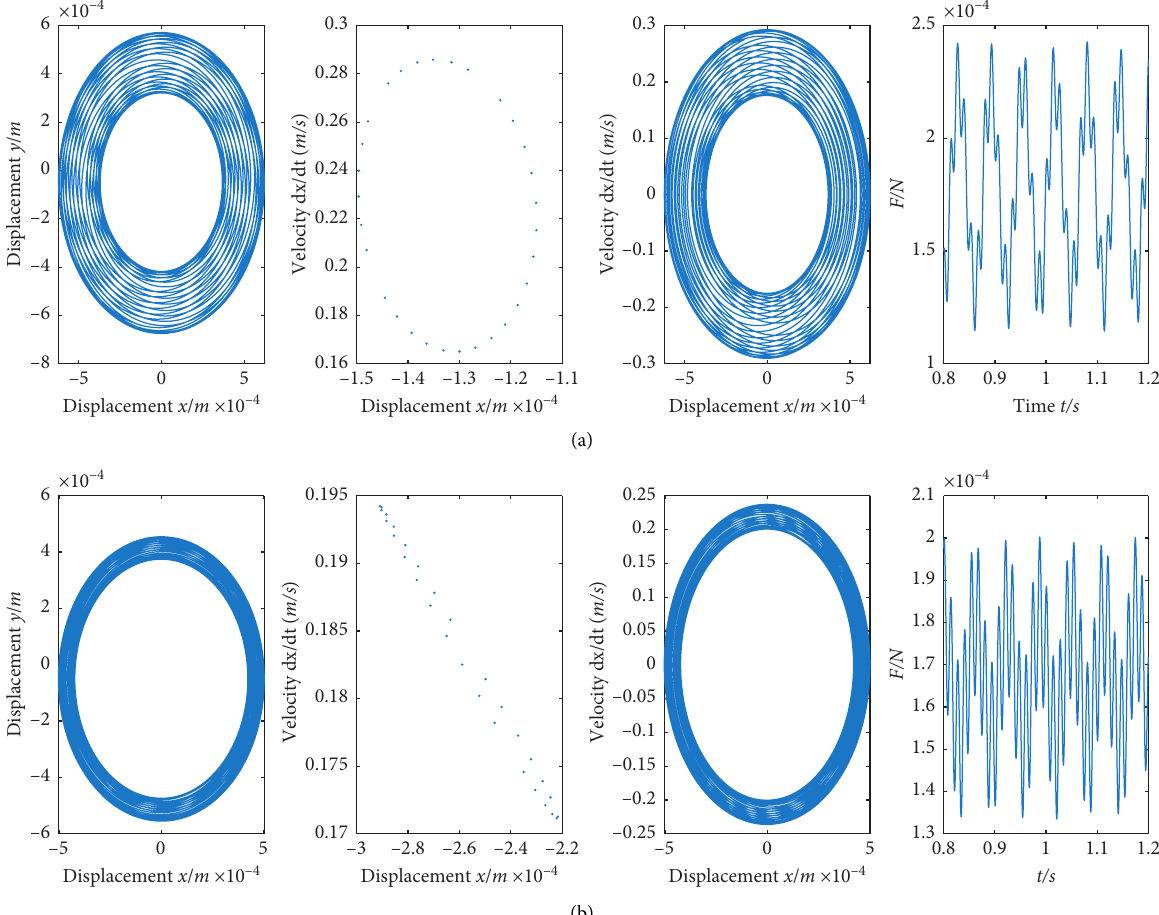
Figure 11: The rotor operating state diagram under different demagnetization states at ω � 471 . 2385rad/s. (a) Demagnetization states ζ � 60% and β � ( π /15 ) . (b) Demagnetization states ζ � 30% and β � ( π /3 )